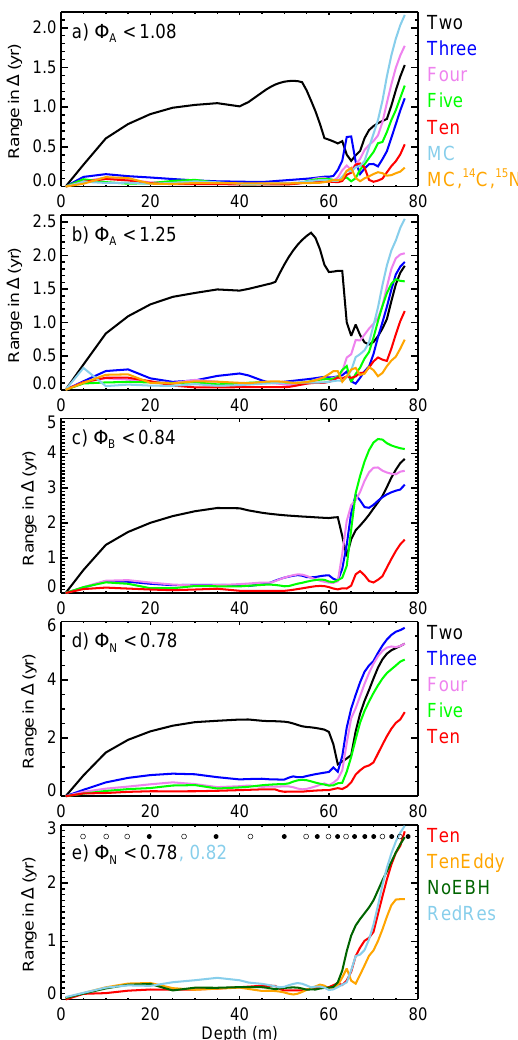
Fig. 5. (a) Depth variation of the range in spectral width of the CO 2 age distribution for Synthetic A representative solu- tions with 8 A < 1 . 08. Cases shown are Subsets Two to Ten, cal- ibration with CH 3 CCl 3 alone (denoted “MC” for methyl chloro- form), and calibration with CH 3 CCl 3 , 14 CO 2 and δ 15 N 2 (denoted “MC, 14 C, 15 N”). Line colours are indicated to the right. (b) Same as in (a) but for 8 A < 1 . 25. (c) Range in spectral width versus depth for Synthetic B representative solutions with 8 B < 0 . 84 in Subsets Two to Ten, with line colours as in (a) . (d) Range in spectral width versus depth for NEEM representative solutions with 8 N < 0 . 78 in Subsets Two to Ten, with line colours as in (a) . (e) Range in spectral width versus depth for NEEM representative solutions with 8 N < 0 . 78 for Subset Ten, case TenEddy and case TenEddy exclud- ing observations corresponding to emissions based histories (de- noted “NoEBH”), and with 8 N < 0 . 82 for case TenEddy excluding about half of the measurement depths (denoted “RedRes”). Filled circles indicate the measurement depths retained, and open circles indicate the depths discarded, in case RedRes. Line colours are in- dicated to the